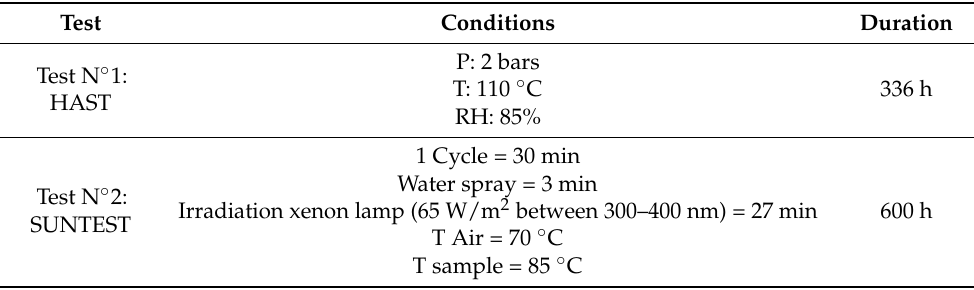
Table 2. Accelerated aging tests